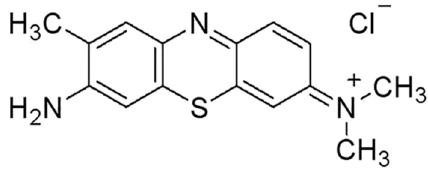
Figure 1: Chemical formula of TB.